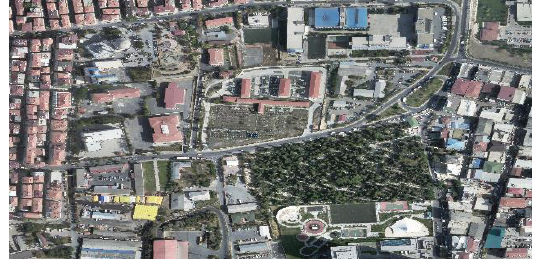
Figure 2. Urban part of study area, site G21.